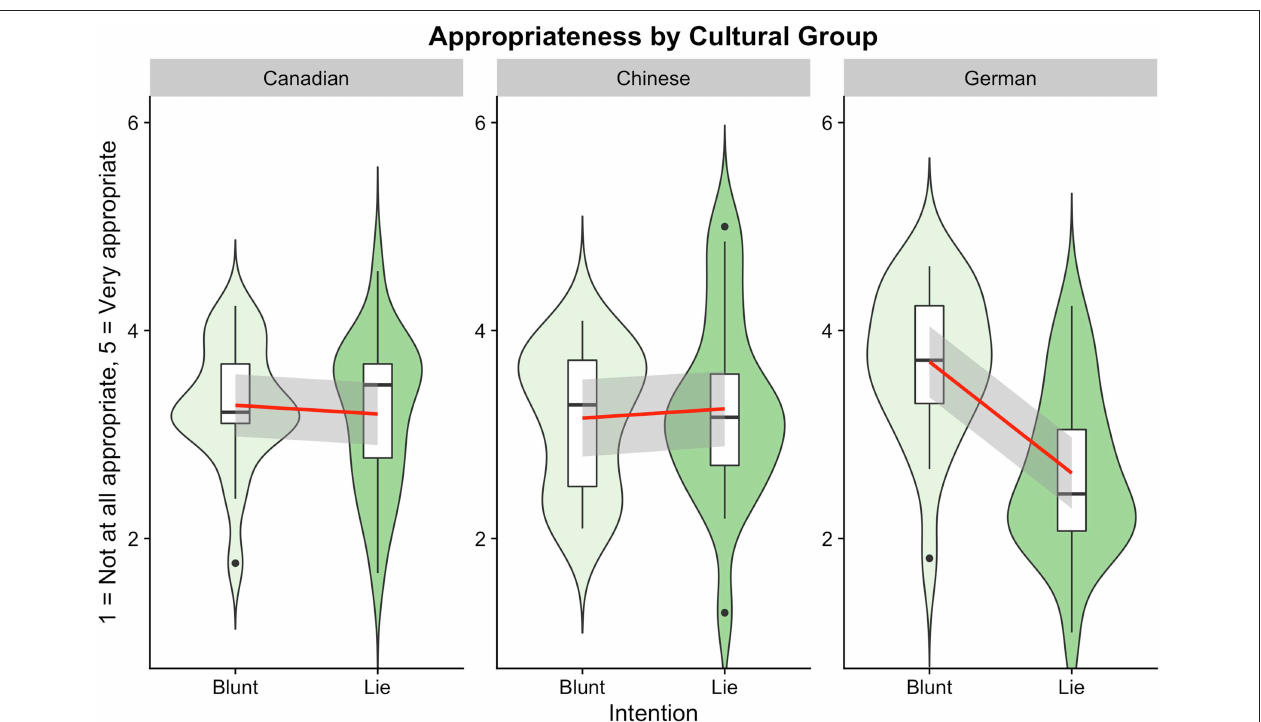
FIGURE 2 | Evaluation of appropriateness in Canadian, Chinese, and German groups. Violin plots (combining density plots and boxplots) showing Likert scale (1–5) results for appropriateness by cultural group and intention. The red lines connect the mean values between conditions resulting from a linear model fit while the transparent gray band represents the 95% confidence